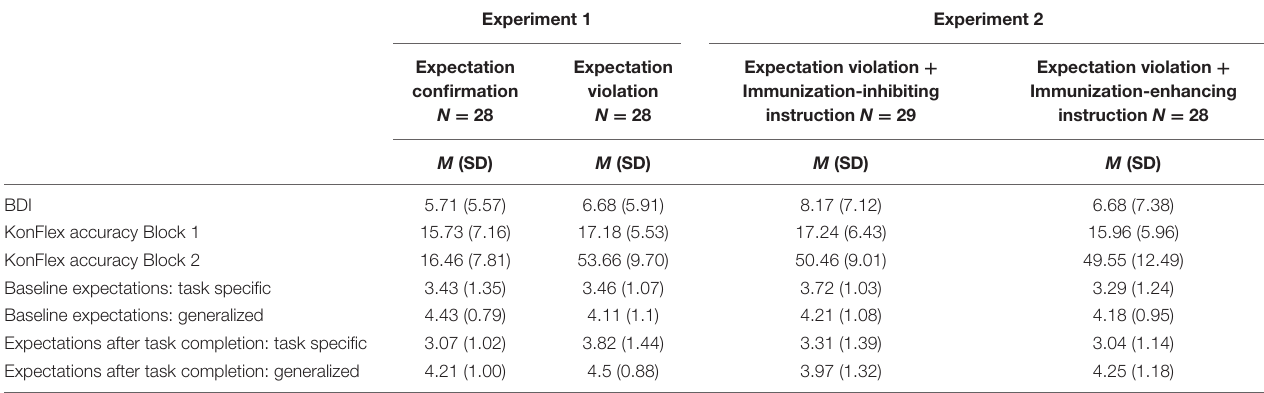
TABLE 2 | Comparison of the four experimental conditions regarding baseline differences ( N = 113).